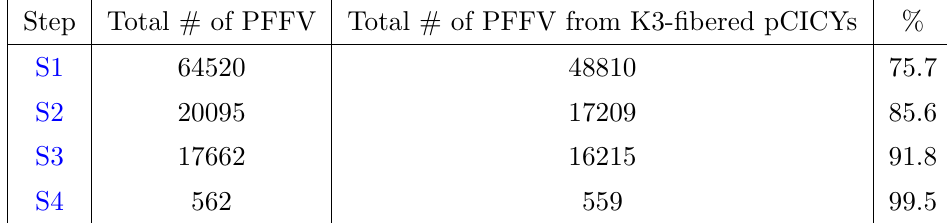
Table 5. Percentage of contributions arising from the K3-fibered CY